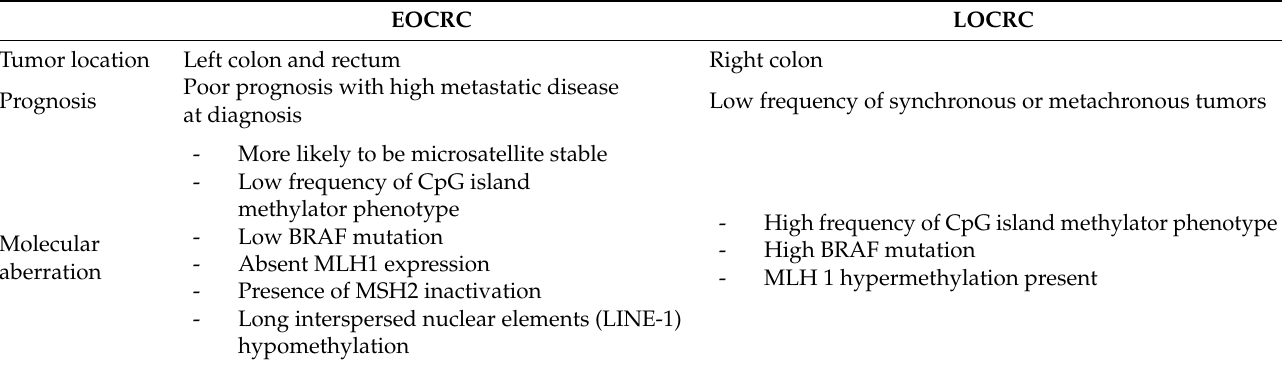
Table 1 is created based on the summary of the published articles by Stoffel and Murphy [14], Ballester, V. et al. [28], and Zaborowski et al.